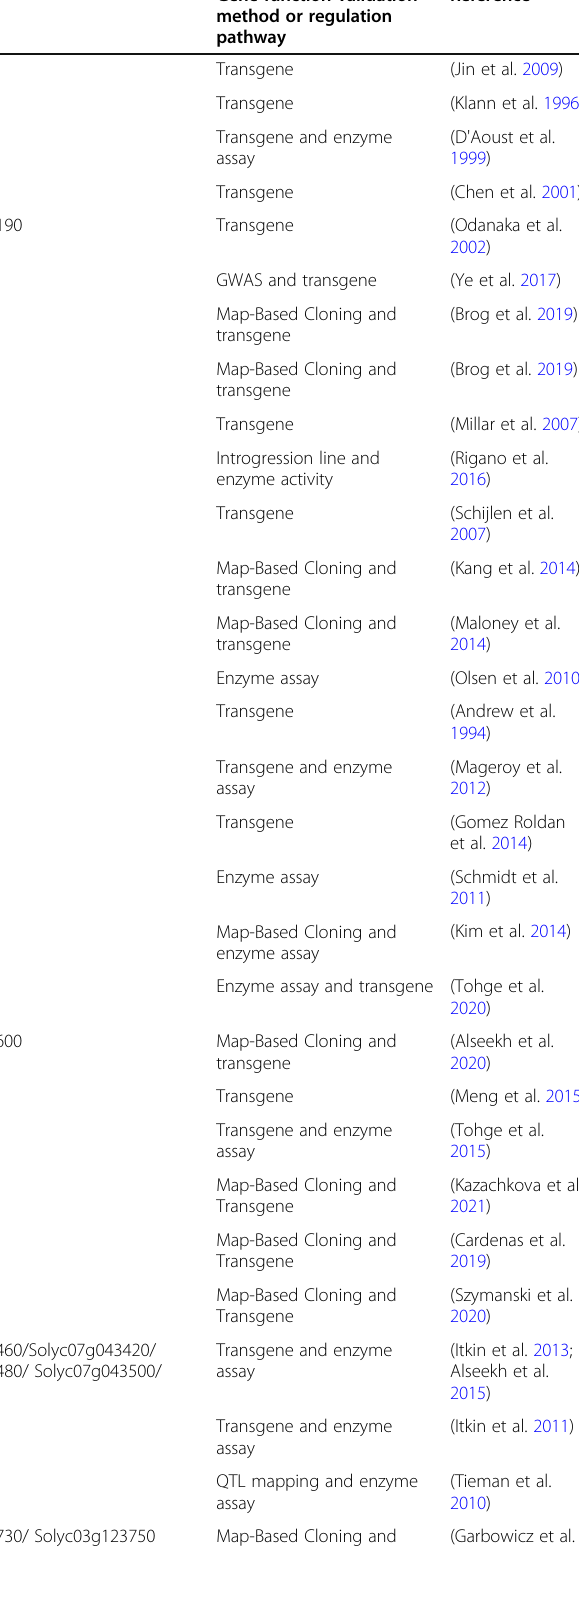
Table 1 Validated structure and transcriptional genes of tomato fruit quality metabolism (Continued) Metabolite pathway or